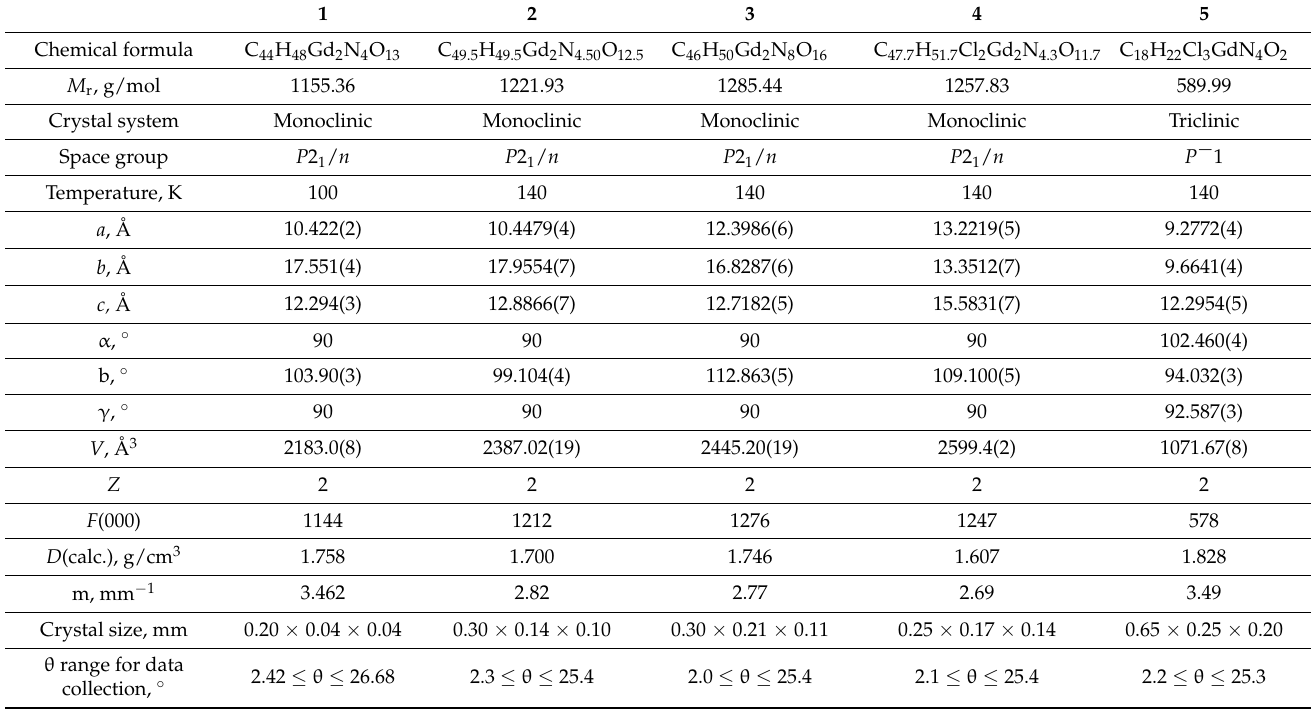
Table A1. Crystallographic data and refinement details for the structures 1 – 5 Table B1. Crystallographic data and refinement details for the structures 1 – 5 .